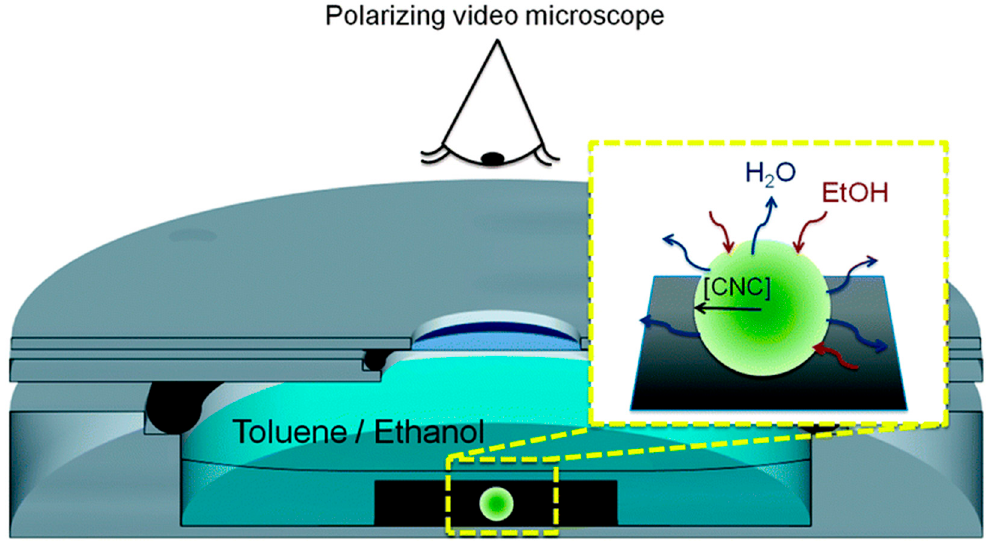
Figure 10. The cell utilized for polarized video microscopy imaging of the decreasing droplets is shown schematically. The CNC droplet (bright green) is captured in reflection mode on a hydrophobic OTS-silicon substrate (black). Water and ethanol diffusion and the resulting radial CNC concentration gradient are depicted. Reproduced from [89].